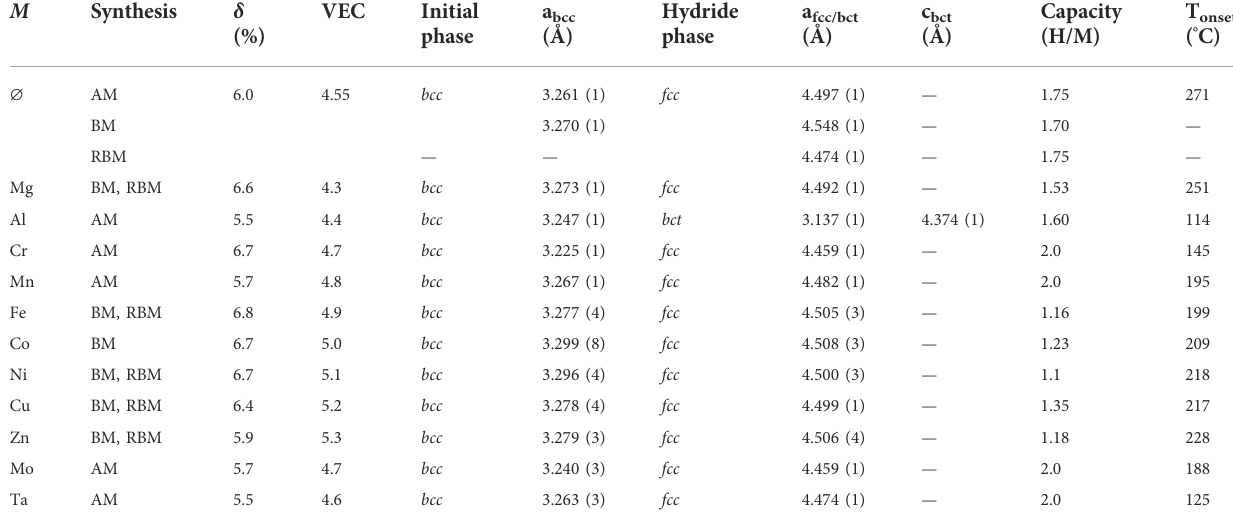
TABLE 1 The synthetic method (arc melting-AM, ball milling under Ar-BM and reactive ball milling-RBM), the empirical parameters ( δ and VEC), the lattice parameters of the initial and hydride phases, the capacity, and the onset temperature of desorption of the series of